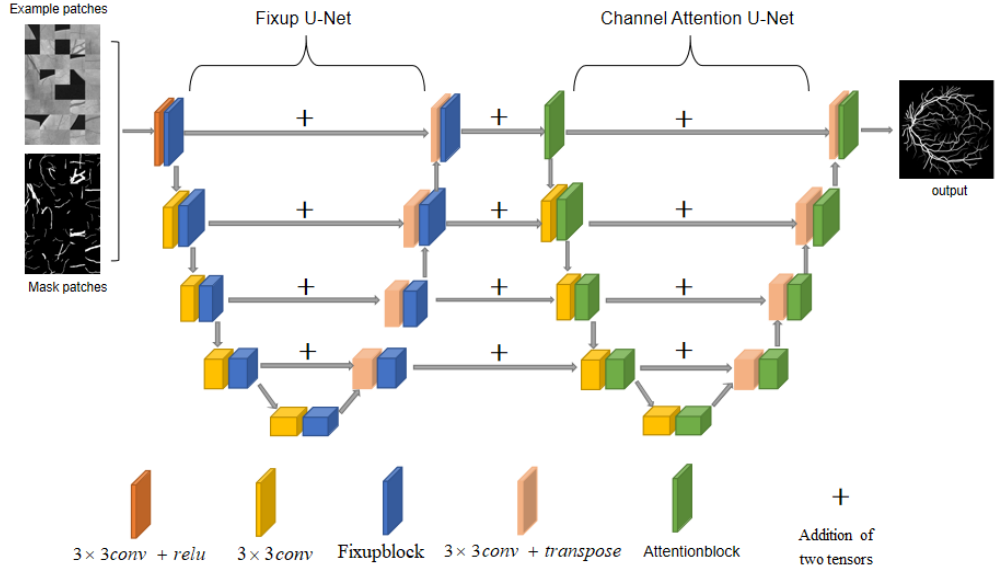
Figure 1. Structure of FAU-net.